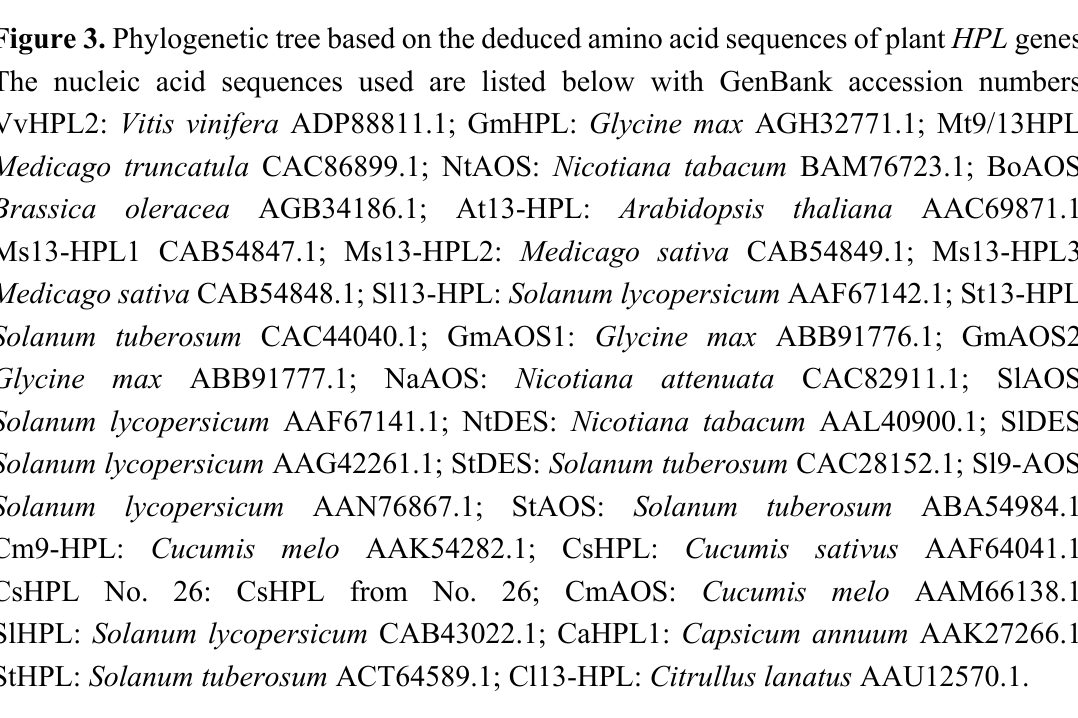
Figure 3. Phylogenetic tree based on the deduced amino acid sequences of plant HPL genes. The nucleic acid sequences used are listed below with GenBank accession